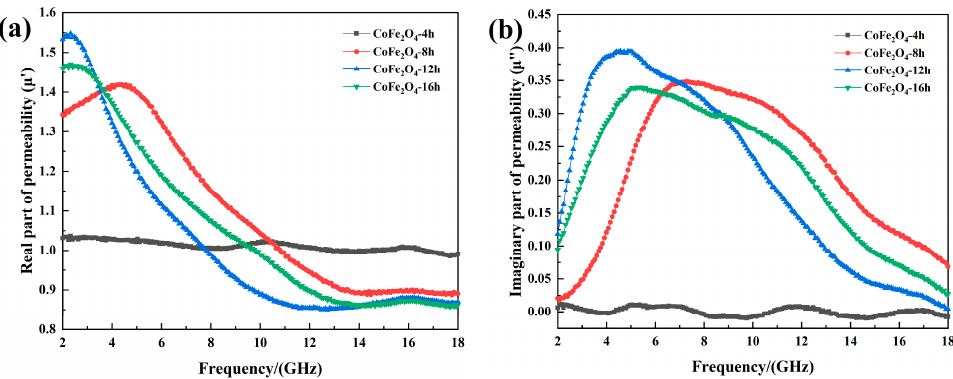
Figure 5. ( a ) The permeability of cobalt ferrite; ( b ) imaginary part of the permeability.